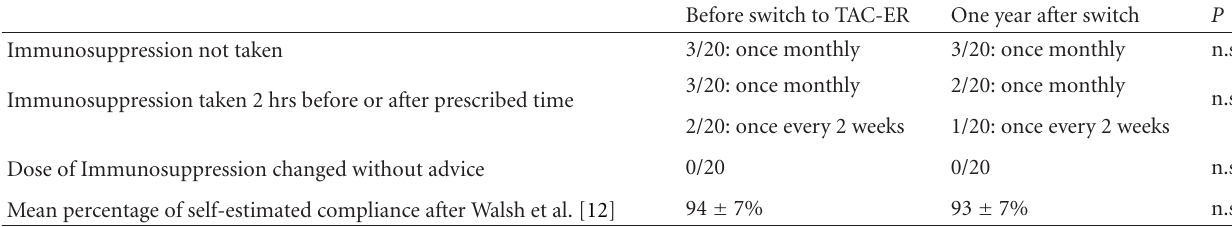
Table 2: Results of The BAASIS-Scale Interview concerning adherence in all patients before the switch to TAC-ER and one year later. Before switch to TAC-ER One year after switch P Immunosuppression not taken 3/20: once monthly 3/20: once monthly n.s. 3/20: once monthly 2/20: once monthly n.s. Immunosuppression taken 2 hrs before or after prescribed time 2/20: once every 2 weeks 1/20: once every 2 weeks Dose of Immunosuppression changed without advice 0/20 0/20 n.s. Mean percentage of self-estimated compliance after Walsh et al. [12] 94 ±